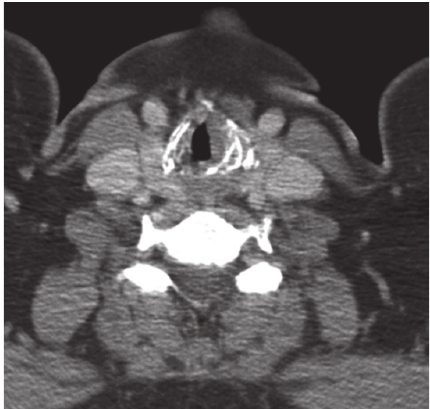
Figure 2: Axial section of CT scan showing left-sided laryngeal asymmetry and homogenous soft tissue mass in the subglottic